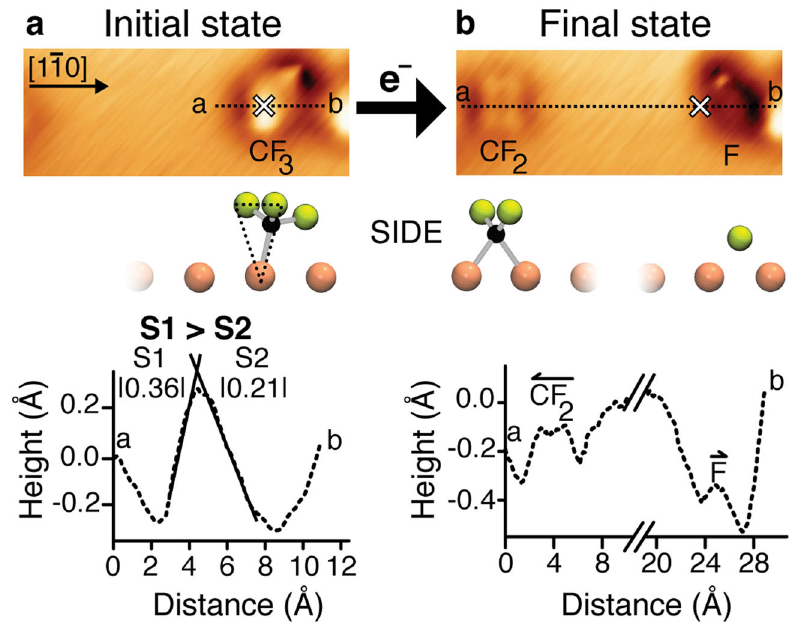
Fig. 1 Electron-induced dissociation of chemisorbed CF 3 gives directed CF 2 and F. a The high-contrast STM image (30 Å × 12 Å, I = 1.0 nA, V = − 5 mV) of a single CF 3 chemisorbed at the Cu(110) surface, in which the backside of the CF 3 is shown to face to the left of the image, is highlighted by a black dashed triangle in the side view. The height-pro fi le of the CF 3 reagent is taken along [1 (cid:1) 10] from a to b . The slopes indicated on this line pro fi le are S1 = | 0.36 ± 0.02| Å/Å and S2 = |0.21 ± 0.01| Å/Å. b The electron-induced dissociation of the CF 3 shows long-range recoil of the dissociation product CF 2 to the left and a short-range recoil of F to the right of the white cross in the STM image, both along a [1 (cid:1) 10] copper row. The height-pro fi le of the two products, a – b , is taken along [1 (cid:1) 10]. The white cross overlaid upon each STM image marks the initial position of the CF 3 prior to